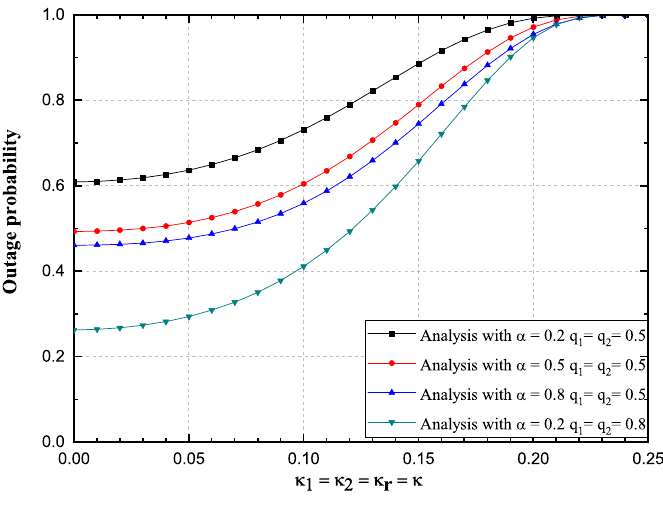
Figure 4. Hoyt fading channels: Outage probability versus κ , 2019 IEEE [24].